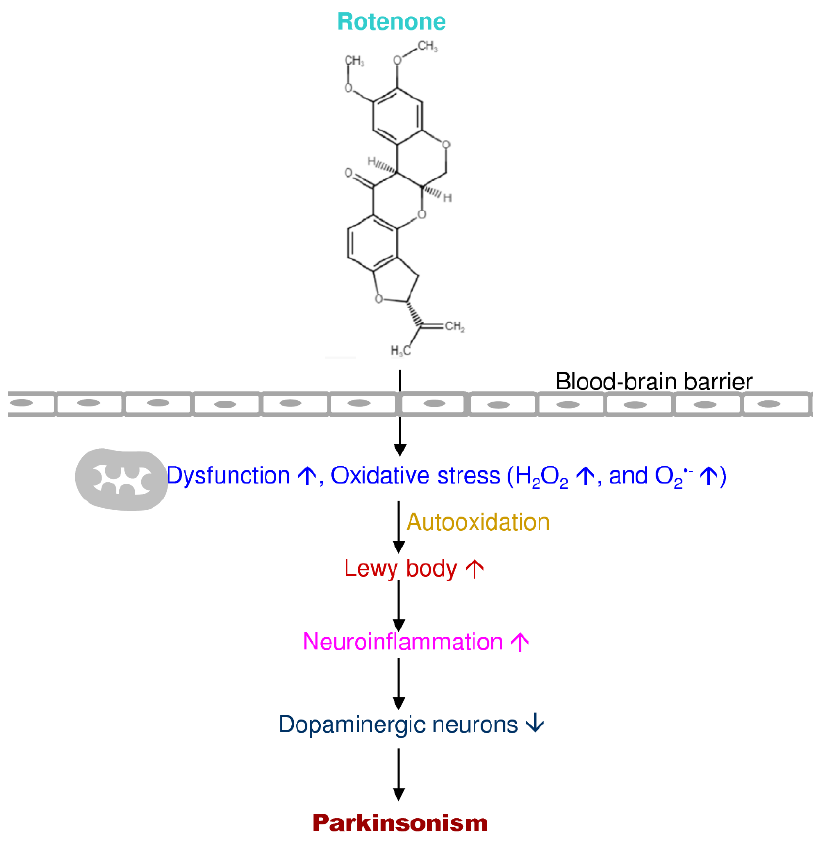
Figure 7. Putative mechanism of action of rotenone in PD progression.